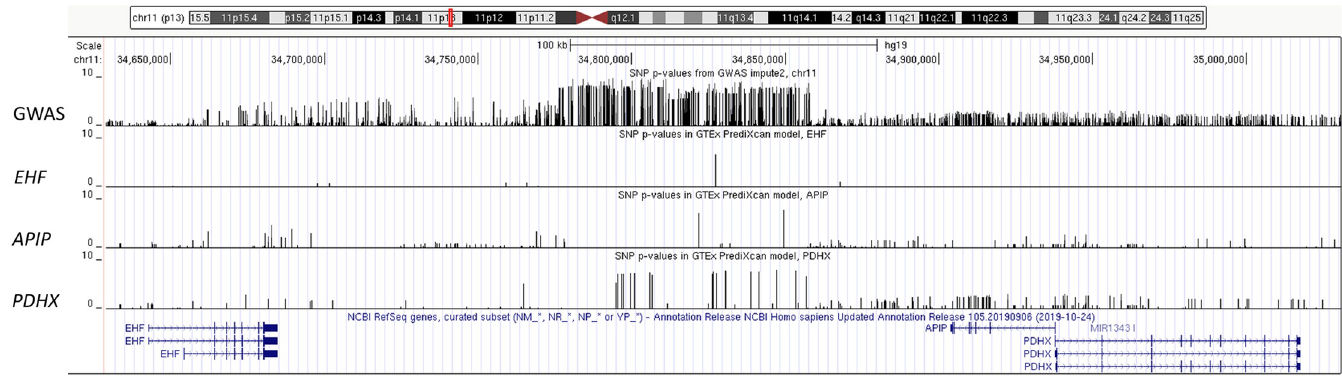
Fig 5. Comparison of predictive model SNPs at chromosome 11 GWAS locus. The -log10 p-values from GWAS analysis were retrieved for cis -SNPs in viable PrediXcan predictive models from 48 GTEx tissues for EHF , APIP , and PDHX . These p-values were formatted as bedGraph files and displayed through the UCSC genome browser (http://genome.ucsc.edu/) as custom annotation tracks, with vertical scales set between 0 and 10. The screenshot of the genome browser shows from top to bottom: GWAS SNP p-values, SNPs used in EHF gene expression imputation model, those for APIP , PDHX , and gene annotation from NCBI RefSeq